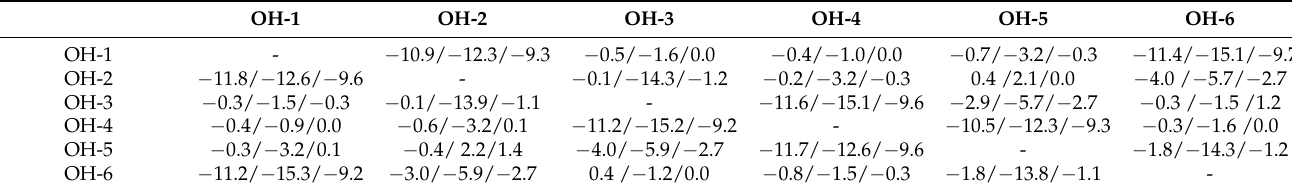
Table 3. I-SAPT interaction energies between hydroxy groups for empty calixarenes. The upper triangle presents the BCX case, the bottom triangle–the CX case, energy values for the al , pc , and wc conformers, respectively, are separated by a dash. Energies in